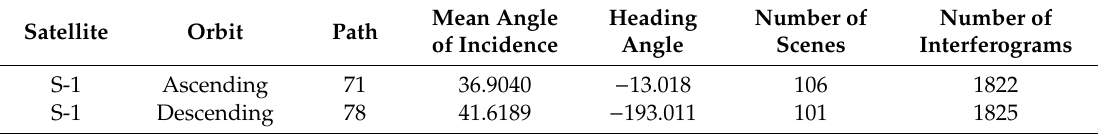
Table 1. Summary of Synthetic Aperture Radar (SAR) data used in this